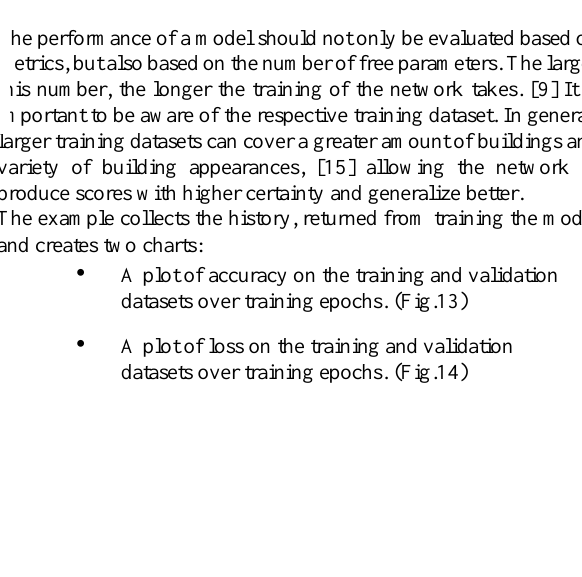
Fig.12 : Test image 3 of nassim Casablanca (unseen